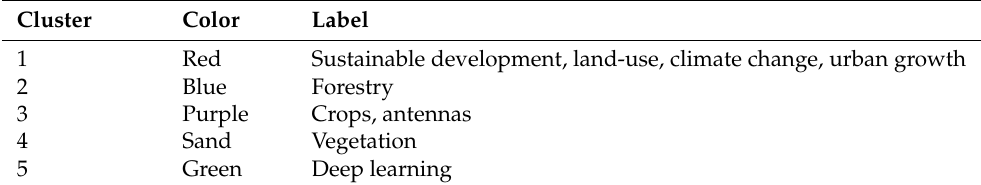
Table 2. Interpretation of co-occurrence clusters displayed in Figure 6.